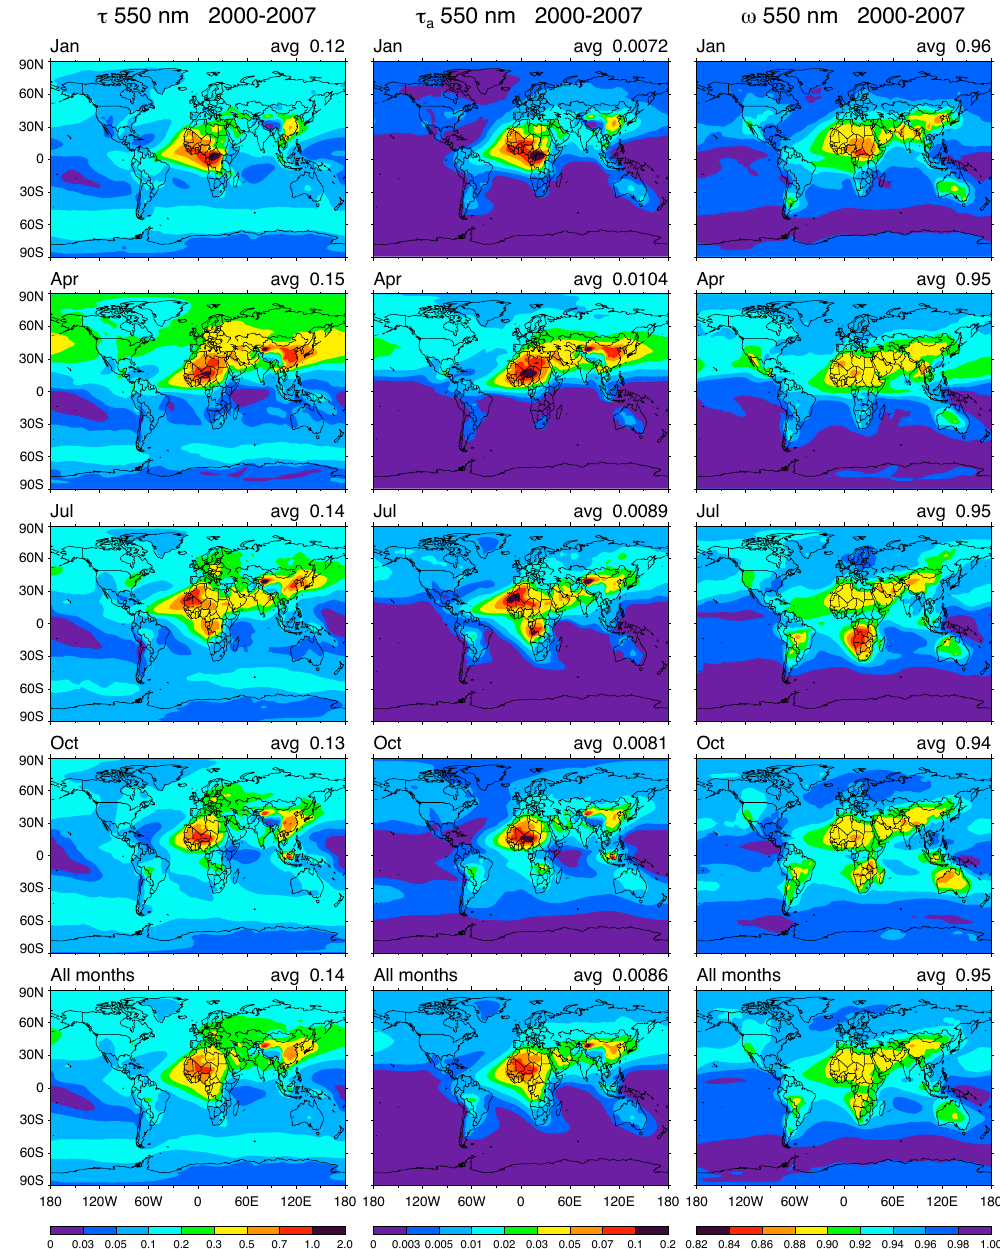
Fig. 8. Global distributions of τ (left column), τ a (middle column), and ω (right column) in January (1st row), April (2nd row), July (3rd row), and October (4th row) averaged over 8-year period from 2000 to 2007. The time averages of τ , τ a , and ω for the entire 8-year period are shown in the last